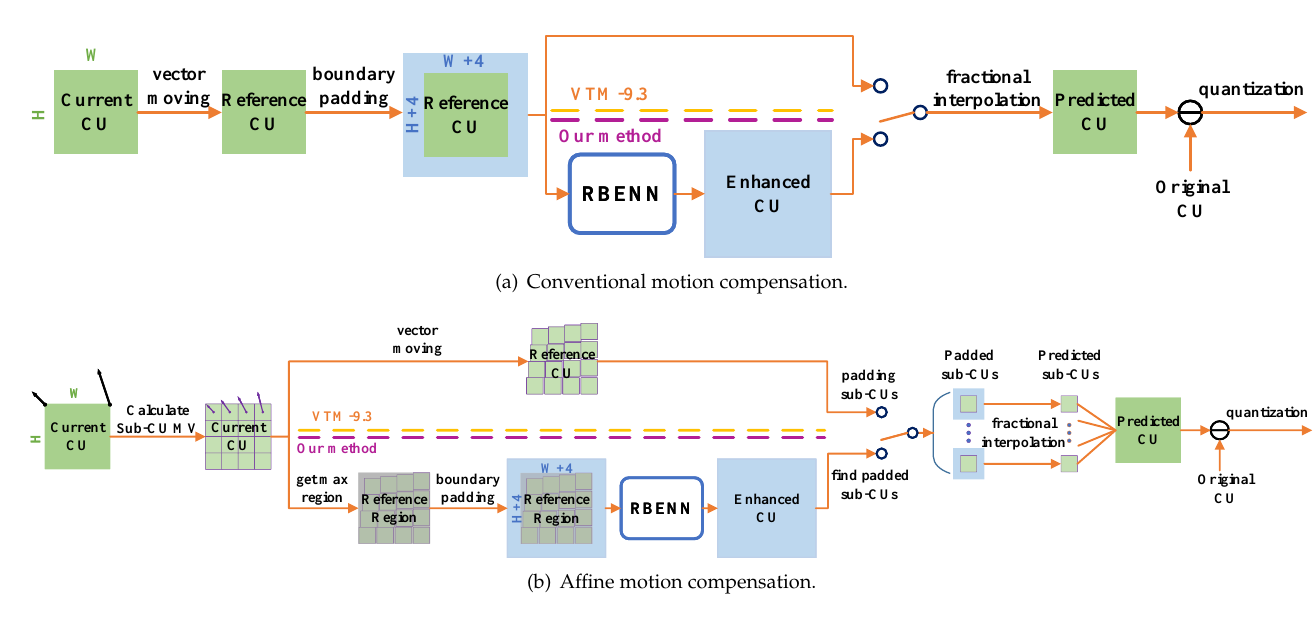
Figure 5. The detail of an RBENN integrated before